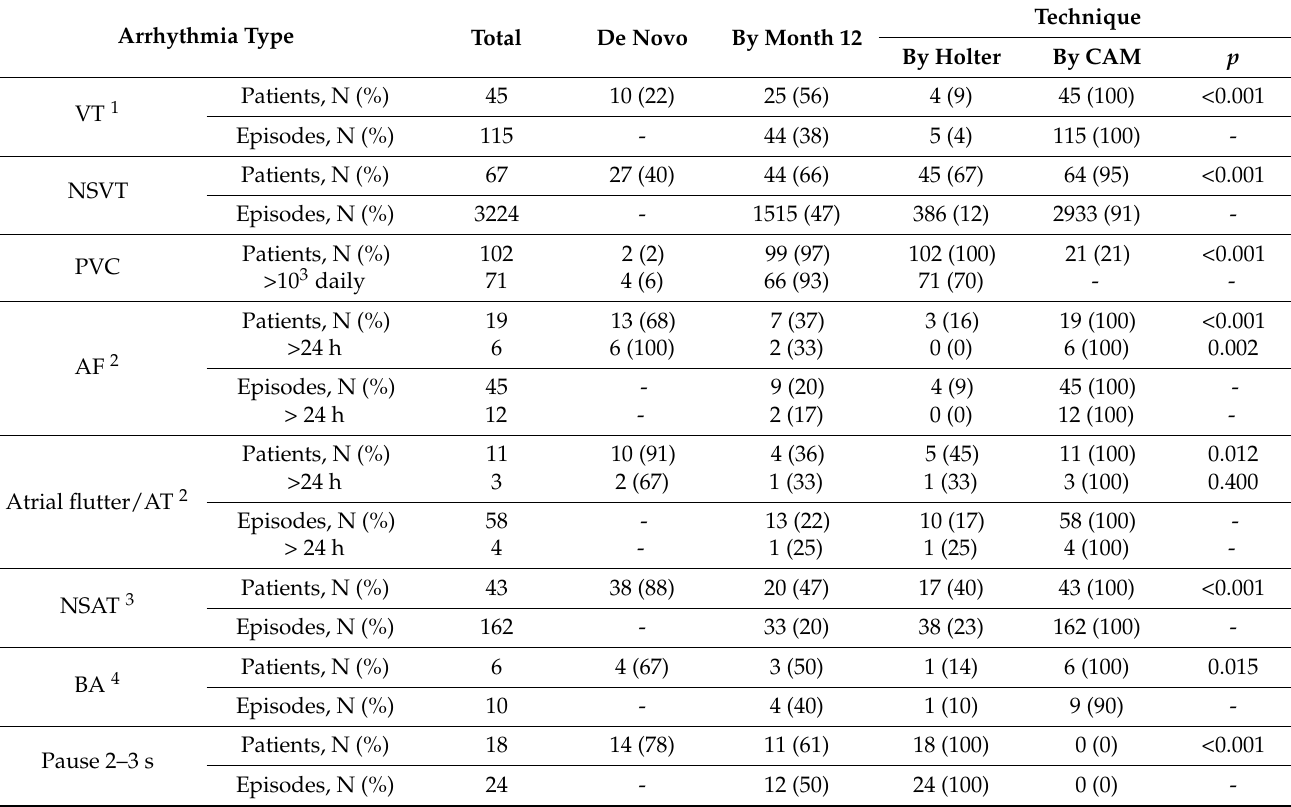
Table 2. Arrhythmia detection during follow